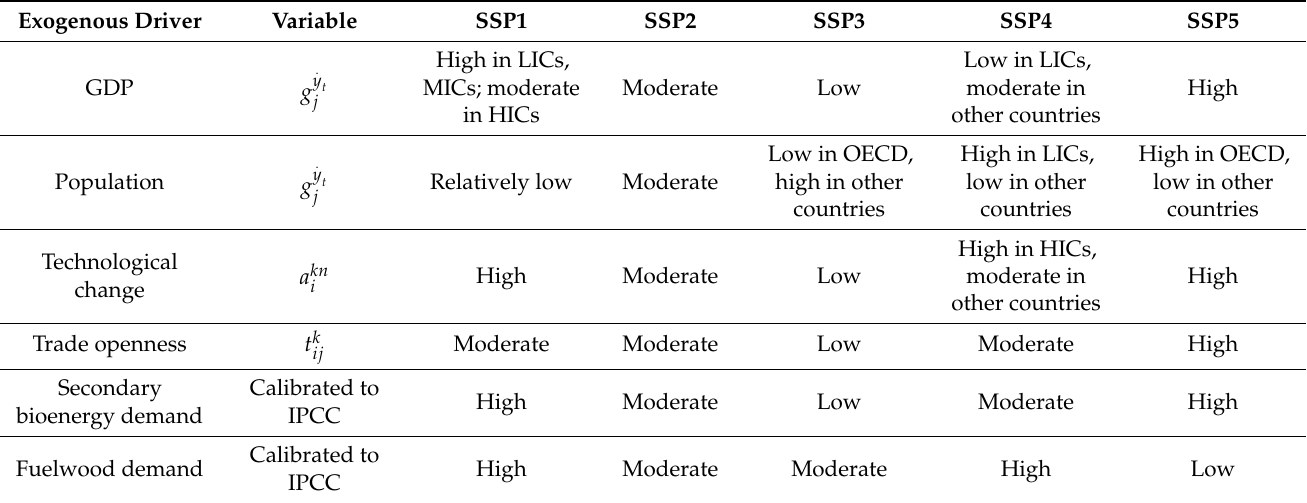
Table 1. Key exogenous drivers of global trends in the SSP scenarios *.